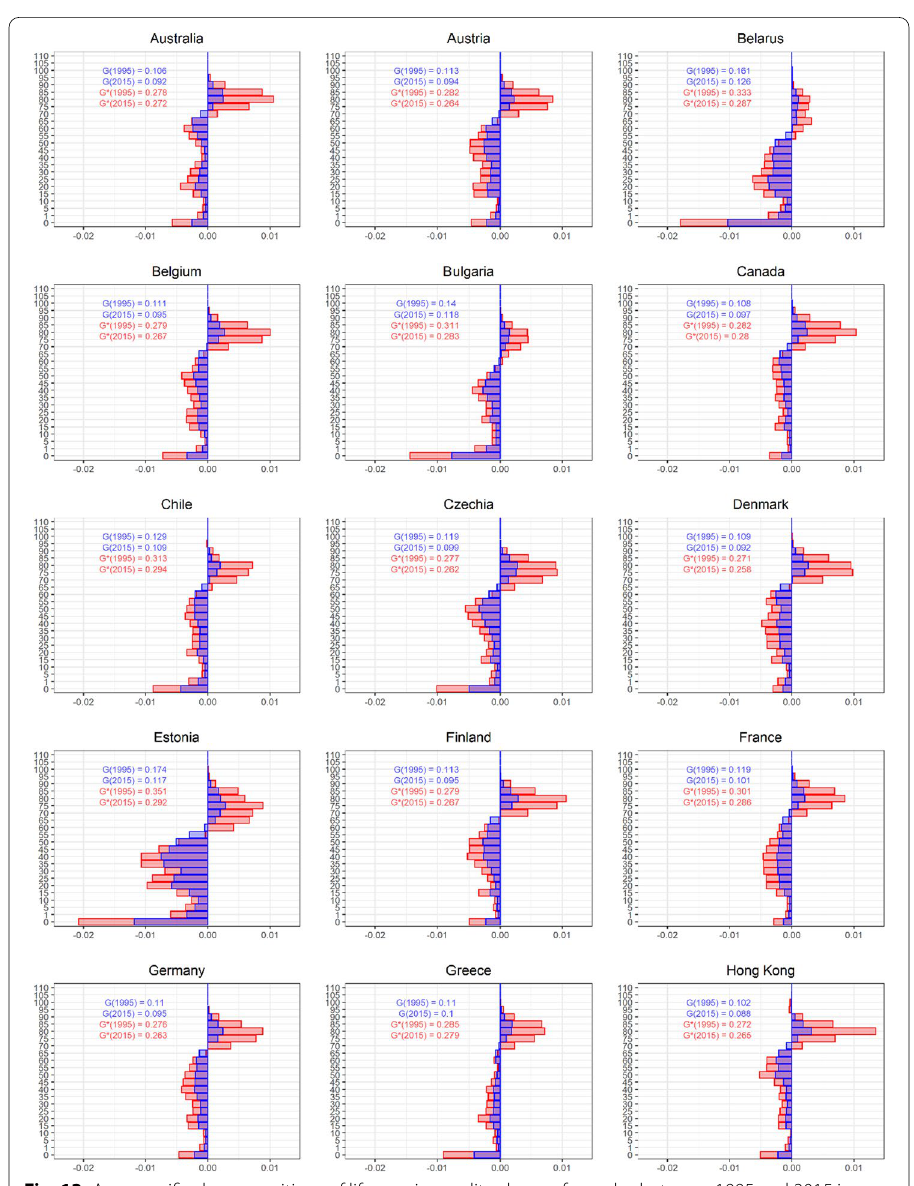
Fig. 13 Age-specific decompositions of lifespan inequality change for males between 1995 and 2015 in HMD countries. The blue bars show the age-specific contributions for the Gini index and the red ones for the normalized Gini index (Source: Authors’ elaboration based on the HMD